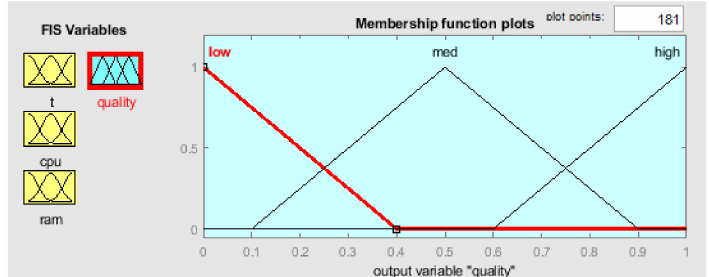
Figure A2. Membership functions of fuzzy sets for the integral quality